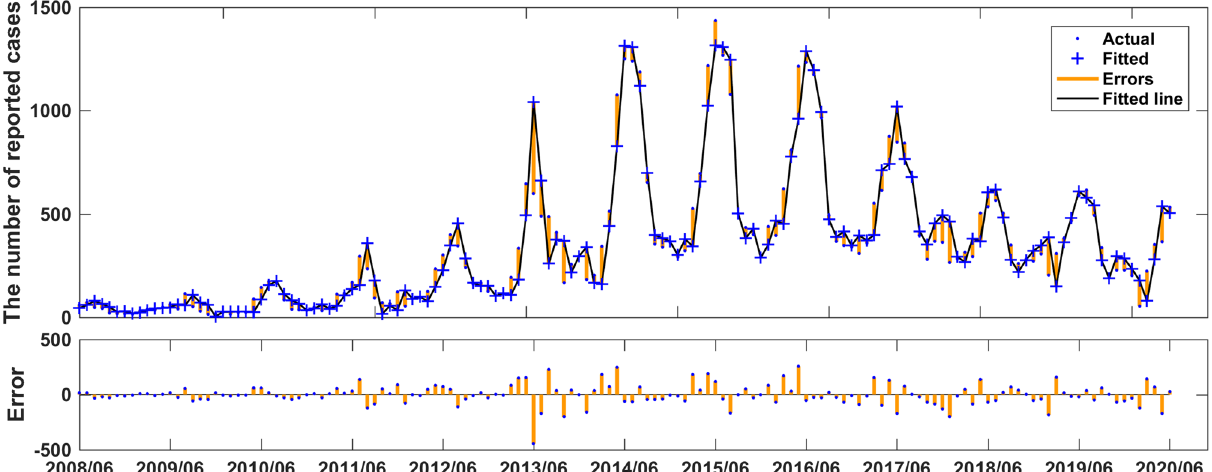
Figure 7. Actual series, fitted series, and residual series of the reported cases sequence of human brucellosis.